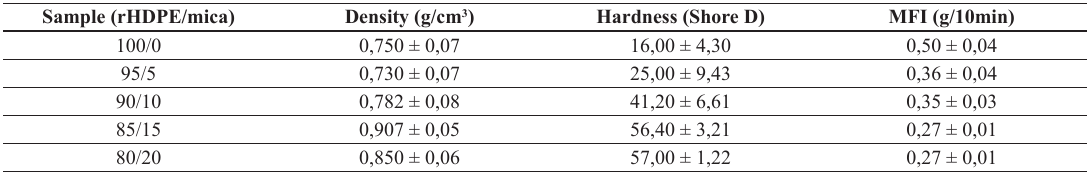
Table 1. Density, Shore D Hardness and MFI of formulations. Sample